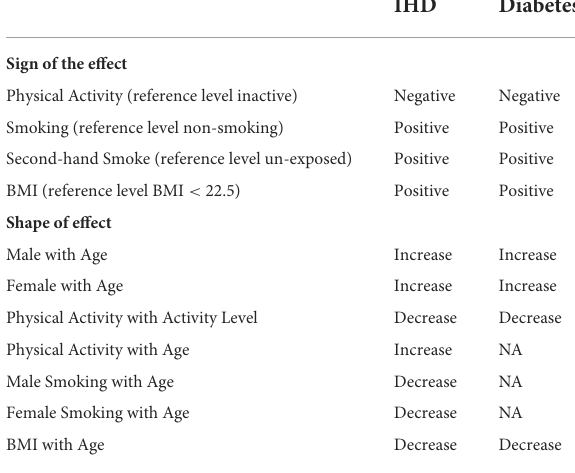
TABLE 2 Qualitative constraints imposed on the qualitative informative hierarchical bayes models based on meta-analysis results of global